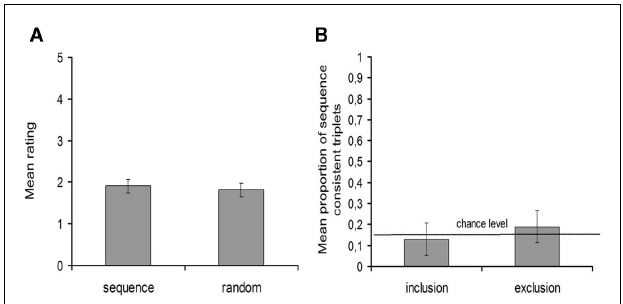
FIGURE 4 | Results on the explicit awareness tests. (A) Mean ratings for sequence trials and random trials. (B) Mean proportion of sequence consistent generated triplets, under inclusion and exclusion conditions. Error bars represent the within-subject 95% confidence